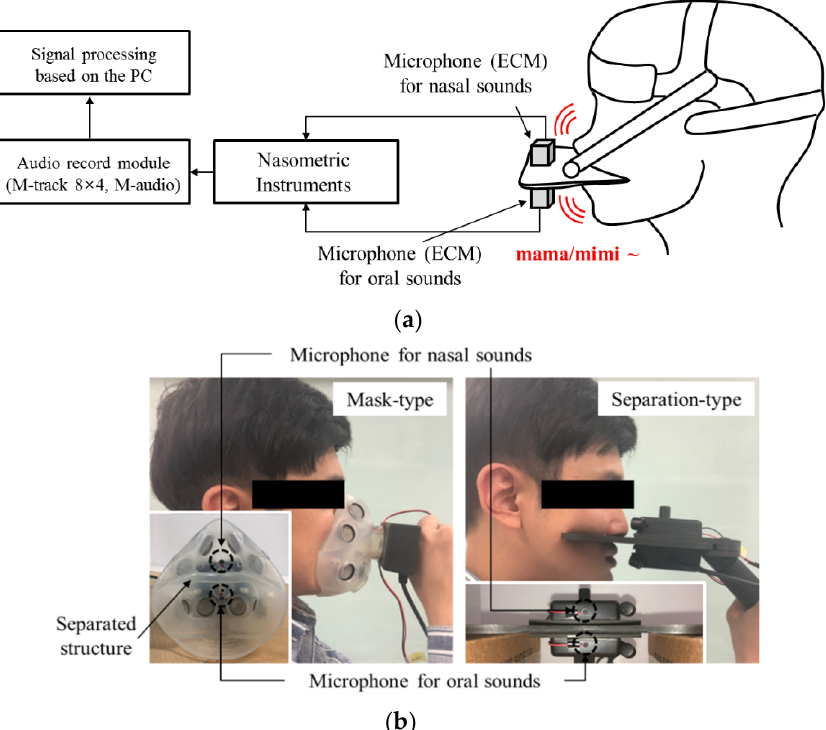
Figure 7. ( a ) Experimental schematic and ( b ) environment picture using the nasometric instruments of the separation-type structure and mask-type structure.